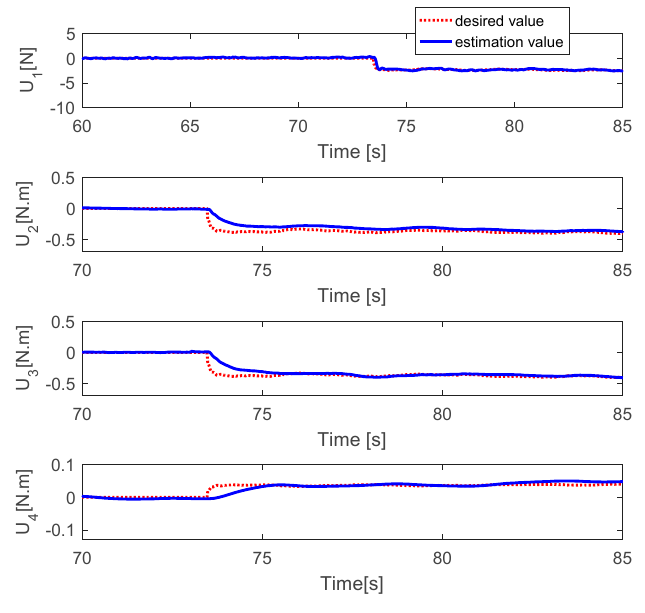
Figure 9. Fault estimation of control inputs.